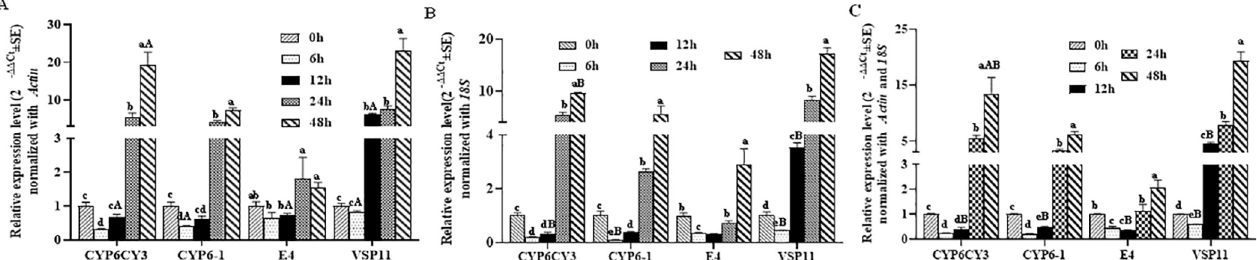
Fig 3. Relative expression levels of target genes in M . persicae after starvation normalized to Actin (A) and 18S (B) alone and in combination (C). Values are shown as the mean ± SEM. Bars with different letters are significantly different from each other ( P < 0.05). Lowercase letters indicate the comparison among different starvation time for one target gene normalized with the same housekeeping gene. Uppercase letters represent the comparison among different normalized genes for one target gene under the same starvation time.